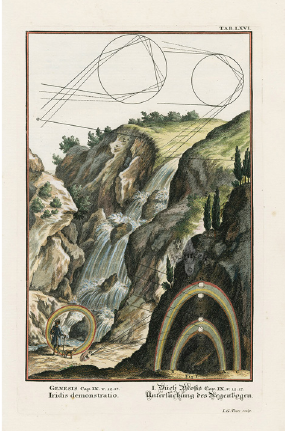
Fig. 1 Scheuchzer, J. J. (1731), Physica Sacra , tab. LXVI, Iridis